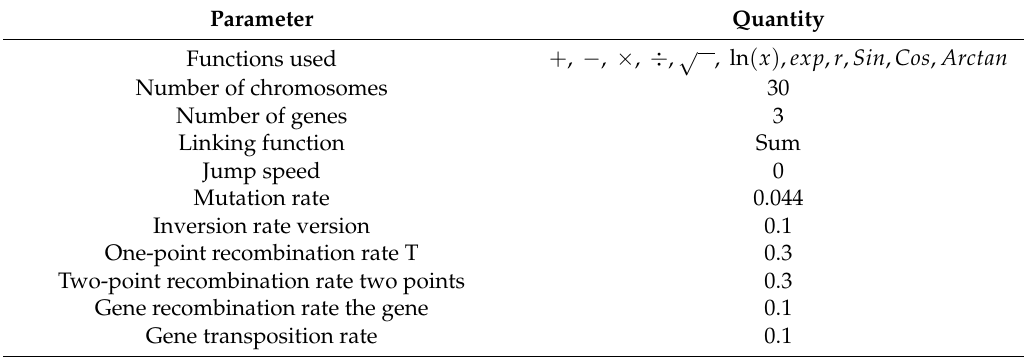
Figure 3. The general form of the initial steps of gene expression programming (GEP) (Alvisi, Mascellani, Franchini, and Bardossy, 2005). Table 1. Parameters used in the GEP method.